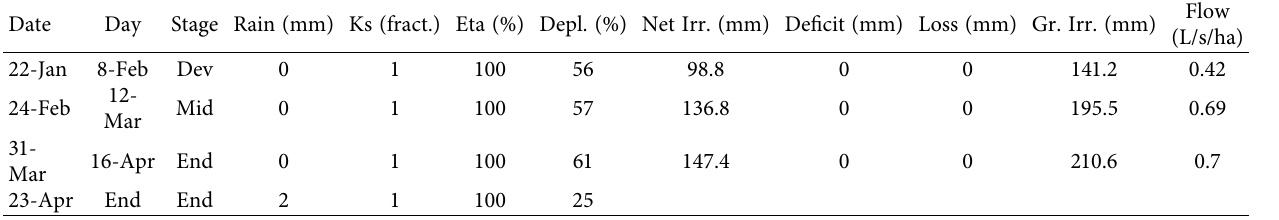
Table 13: Wheat irrigation schedules.